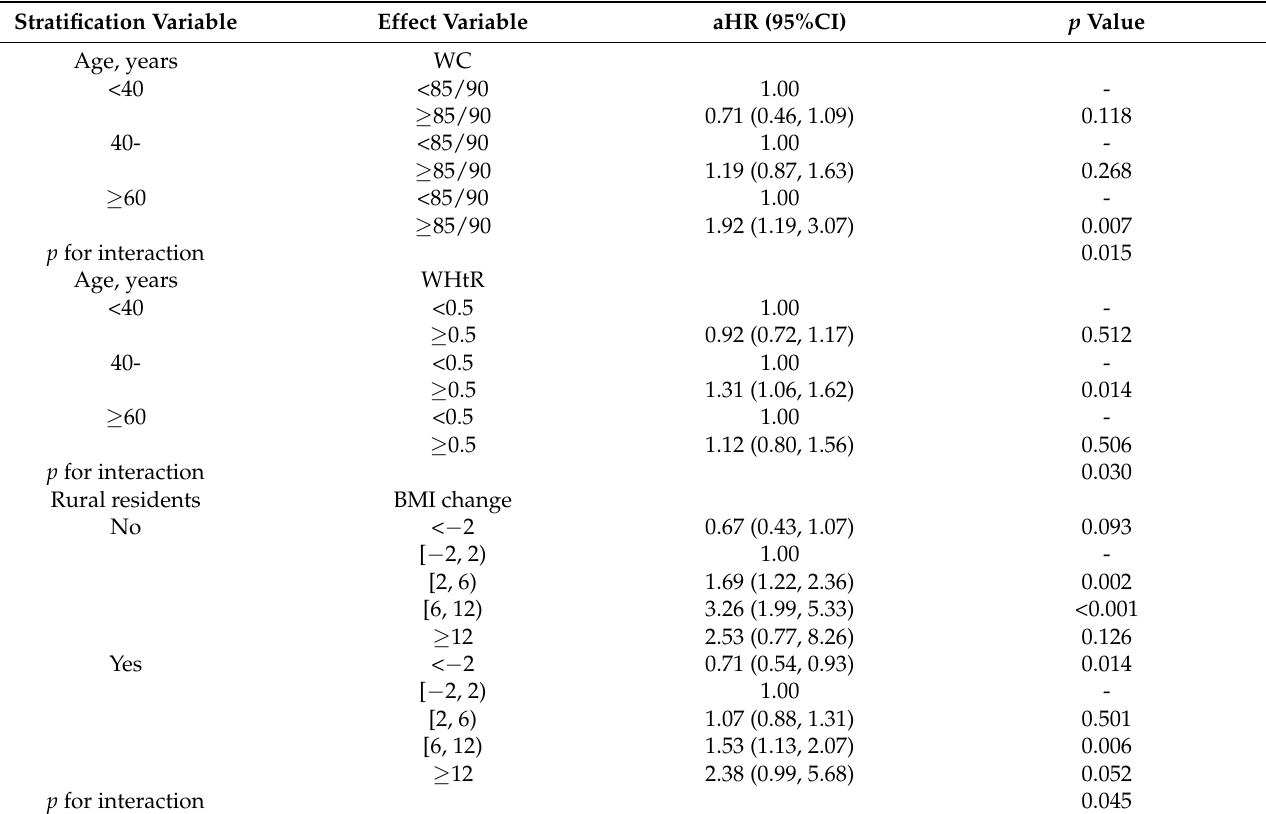
Table 4. Stratification analysis of different anthropometric risk factors for incident dyslipidemia by age groups and